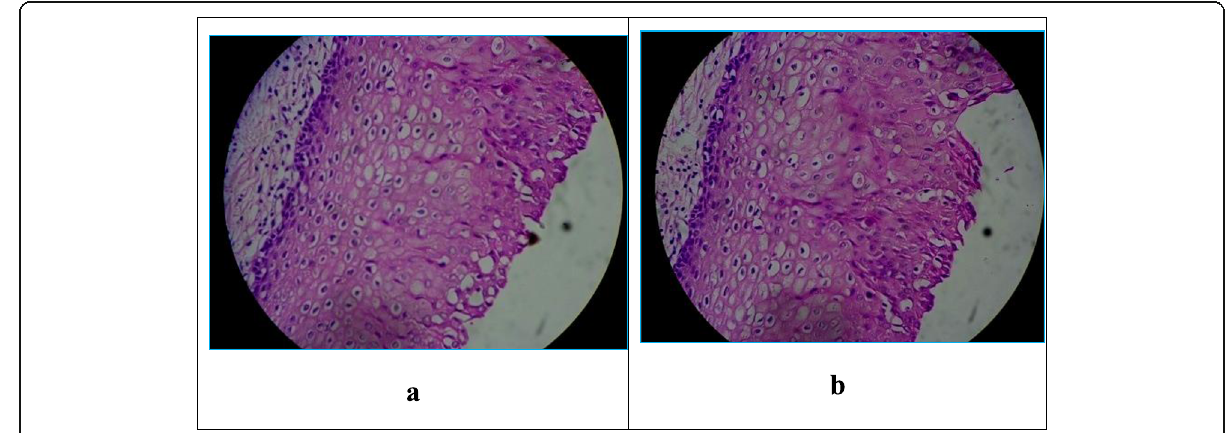
Fig. 6 Histopathological images of a normal mucosa and b mucosa exposed to